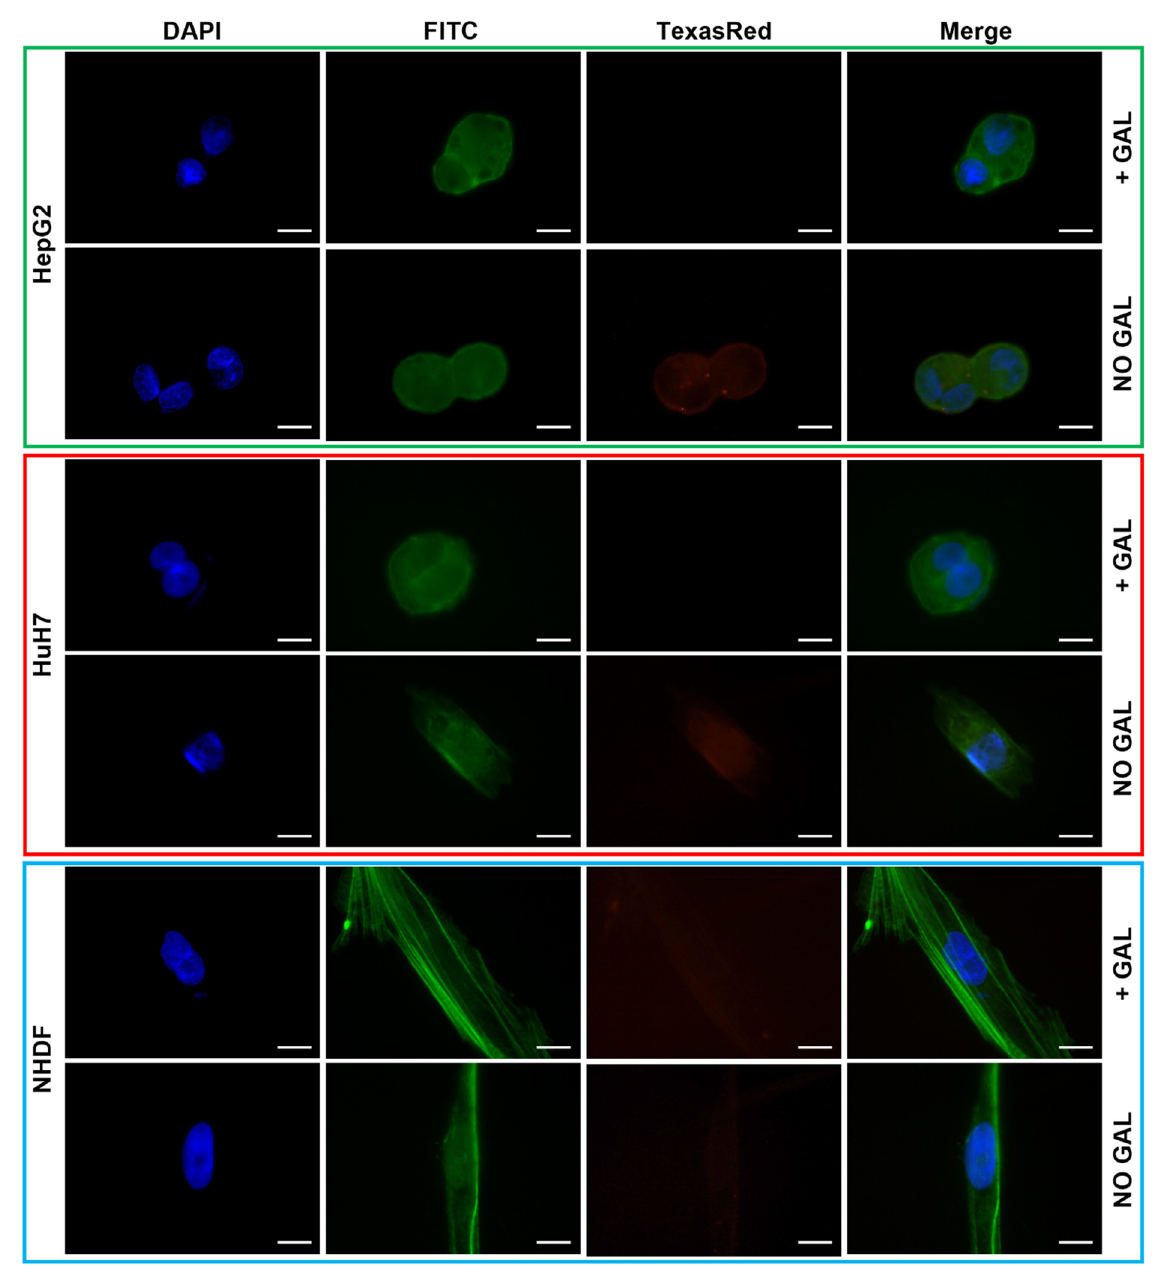
Figure 11. Uptake studies on hepatocarcinoma cell lines and fibroblasts after 4 h incubation with labelled drug empty NPs containing AuNRs-C 12 . Scale bar 10 µm.